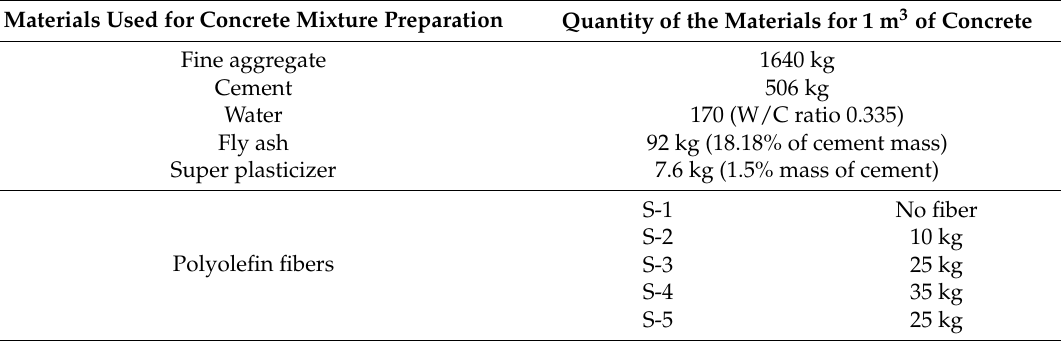
Figure 1. Properties of polyolefin macro fibers. Table 1. Mixing proportion of concrete.